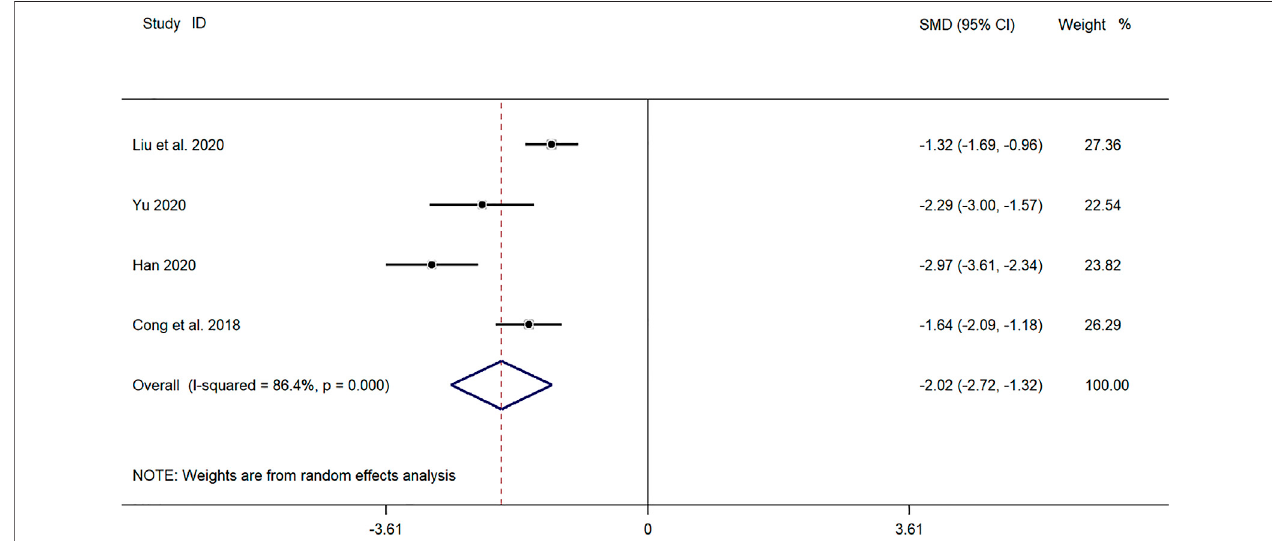
FIGURE 5 | Meta-analysis of forest plots comparing the time for disappearance of cough in the experimental and control group.